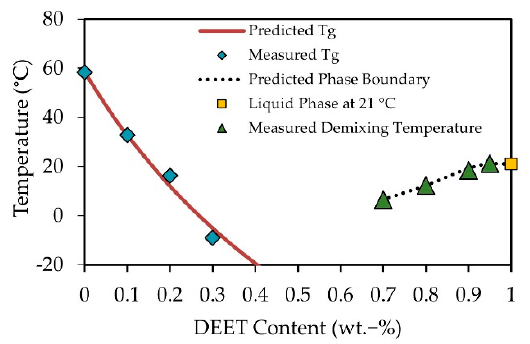
Figure 4. Phase diagram of the polymer/solvent system PDLLA/DEET containing information about glass transition temperatures in low-DEET-content samples (blue diamond symbols) and temperatures of demixing of high-DEET-content samples (green triangle symbols).